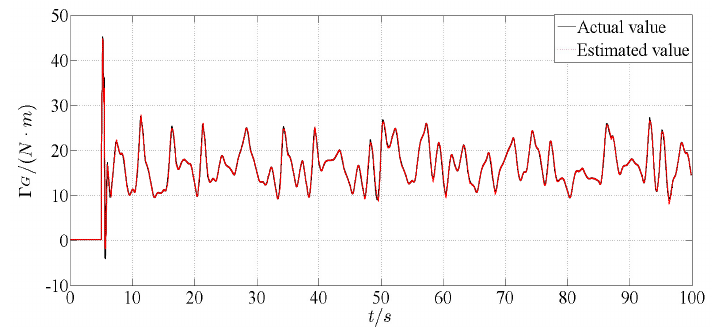
Figure 4. The actual and estimated values of electromagnetic torque Γ G.